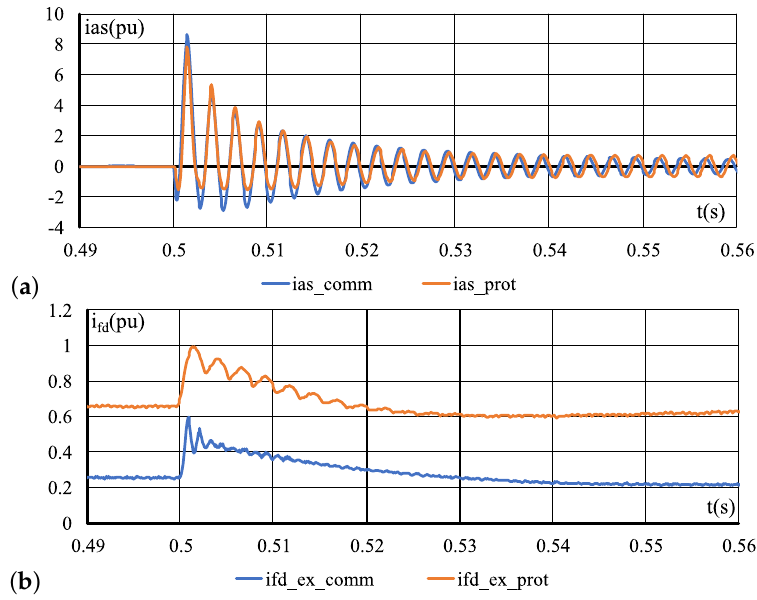
Figure 13. Measurement of armature and exciter currents during transient short circuit test: ( a ) armature currents; ( b ) exciter currents (ias_comm, ifd_ex_comm—results for salient pole generator, ias_prot, ifd_ex_prot—results for non-salient pole